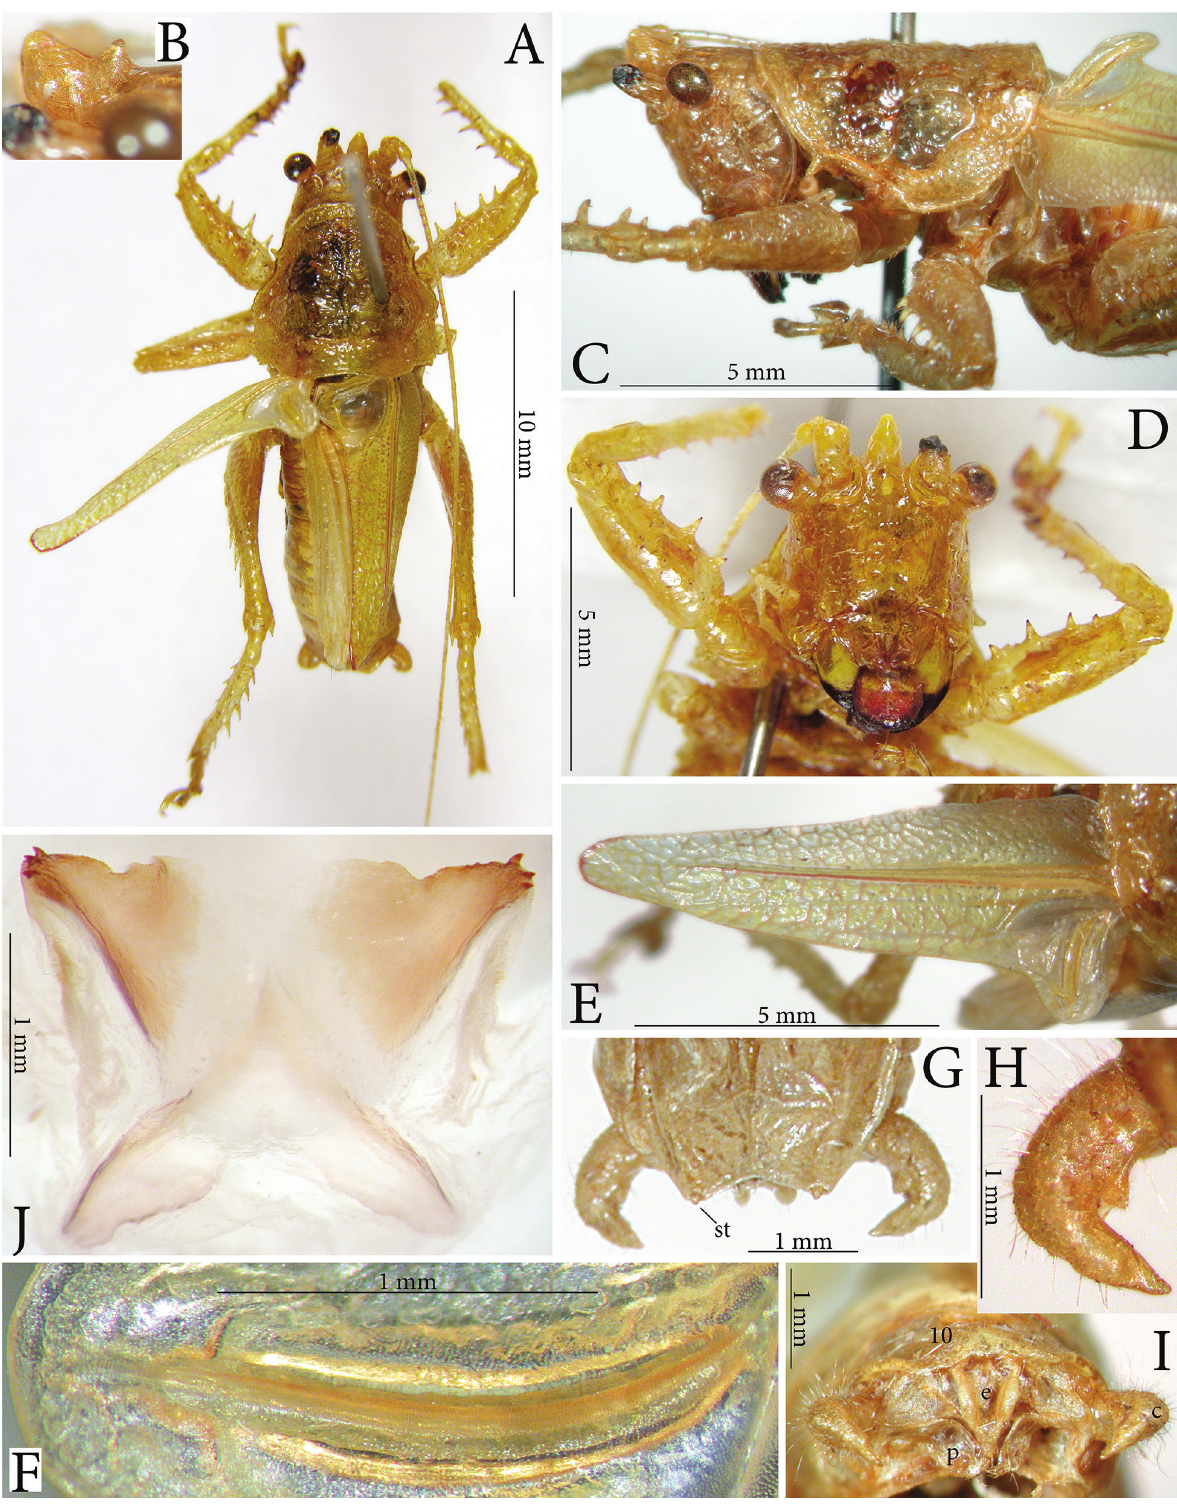
Figure 7. Depressacca kinabalu sp. nov. male holotype: A habitus dorsal view; B fastigium verticis lateral; C head, pronotum and base of tegmen lateral; D face; E left tegmen; F stridulatory file; G subgenital plate and cerci in ventral view; H left cercus in dorsal view; I tip of abdomen in apical view; J titillators of phallus. Abbreviations: 10 tenth abdominal tergite, c cercus, e epiproct, p paraproct, st